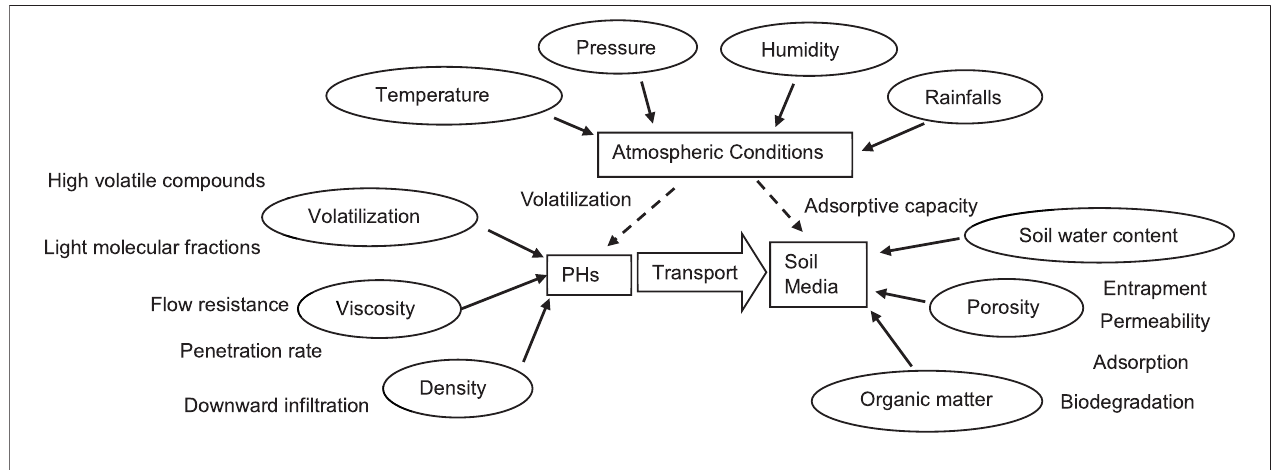
FIGURE 1 | The key factors in fl uencing the interaction between PHs and soil media.